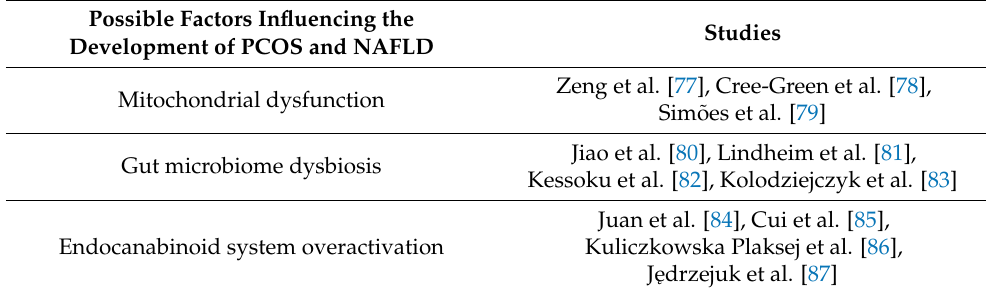
Table 4. Possible new pathophysiological mechanisms involved in the development of NAFLD in PCOS women.